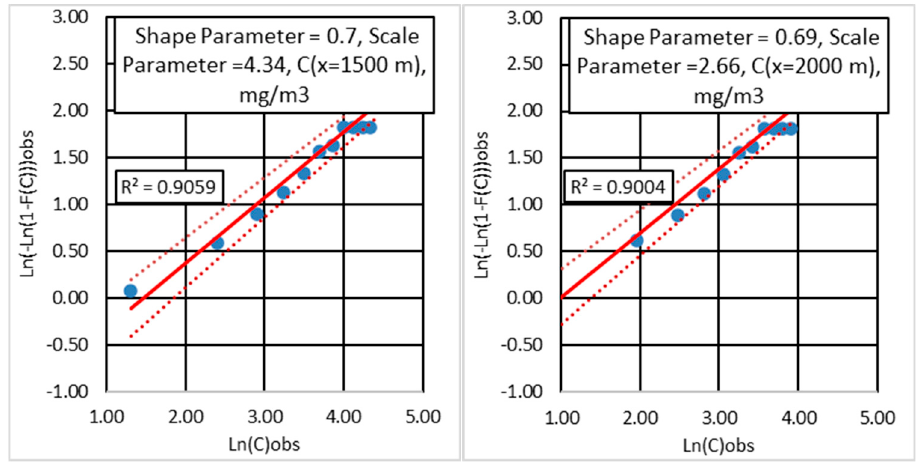
Figure 16. Weibull descriptors and lower and upper confidence level of air pollution concentration, x = 1500 m ( left ) and x = 2000 m ( right ), NO x